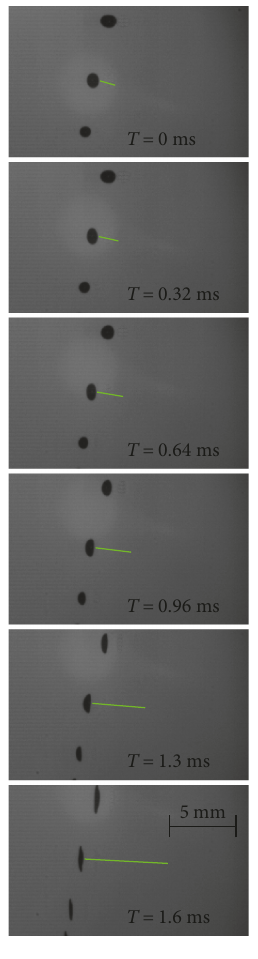
Figure 17: Counterpart of Figure 15 for droplets in the airfoil leading edge region. The slip velocity is superimposed in green color.